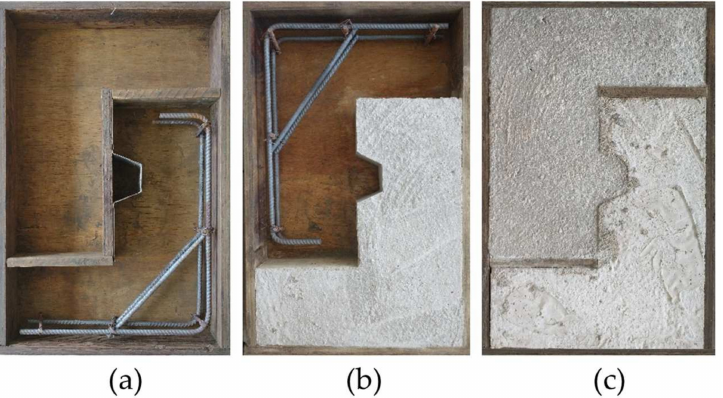
Figure 7. Stages of casting the specimens: ( a ) wooden forms; ( b ) casting the part that receives the key; ( c ) concreting the key part.